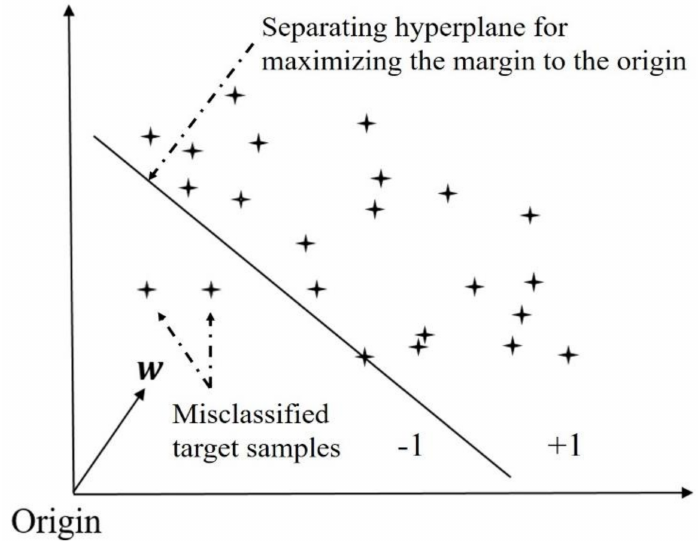
Figure 5. A conceptual illustration of the OCSVC method. The characters “+1” and “ − 1” denote the target class and the outlier class, respectively.